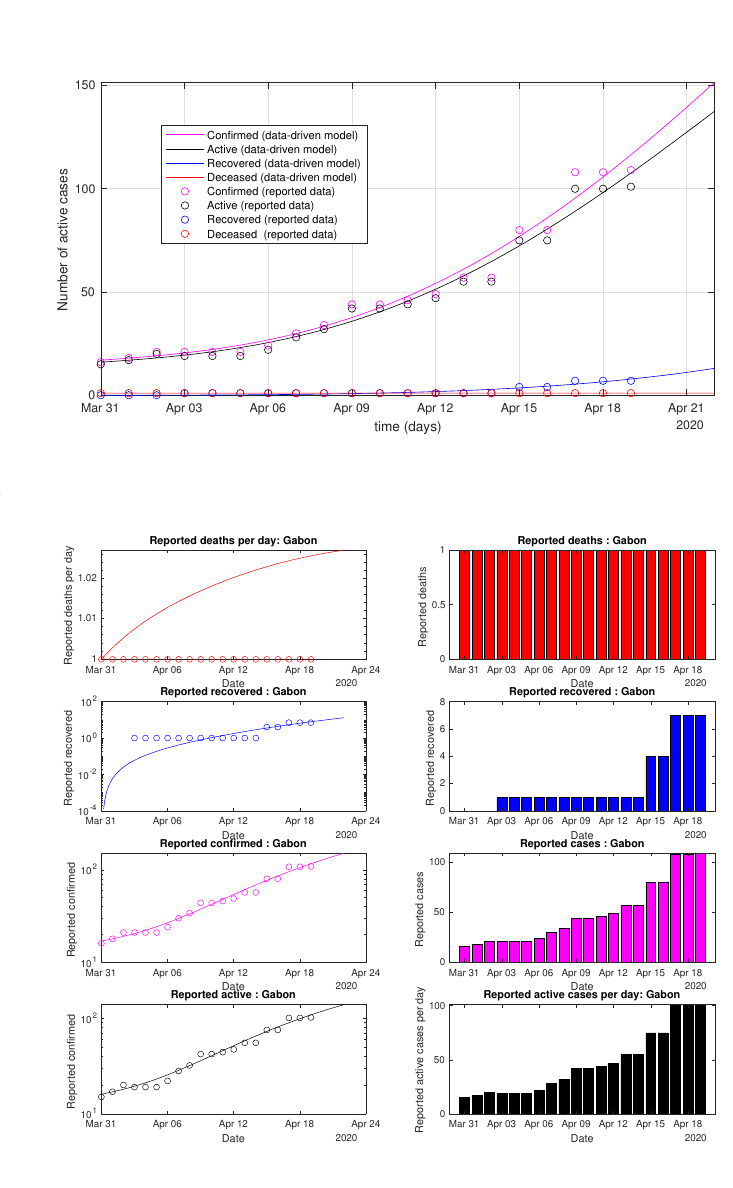
Figure 63. Gabon: data vs.